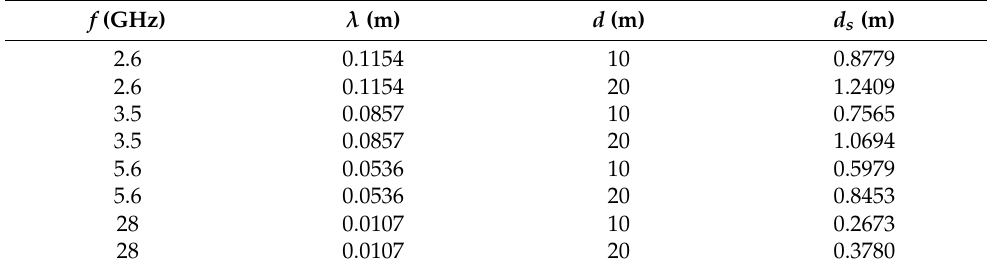
Table 4. Recommendations for 3 × 3 MIMO system of virtual coupling train.